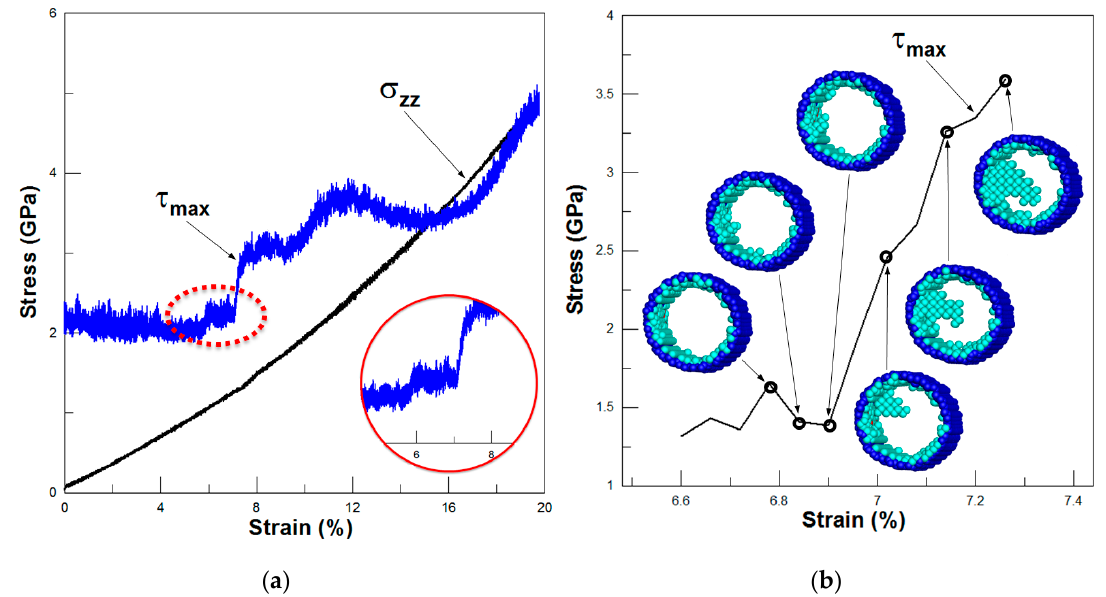
Figure 4. ( a ) MLS stress-strain curve; ( b ) atoms of phase transformation (cyan) in stress-strain curve (atoms near the surface are screened out).